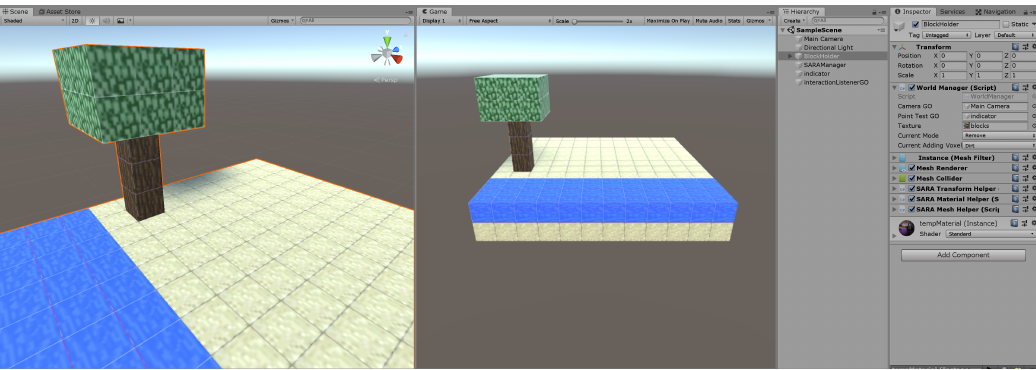
Figure 12. Overview of the five steps in which the process of developing with SARA is divided.